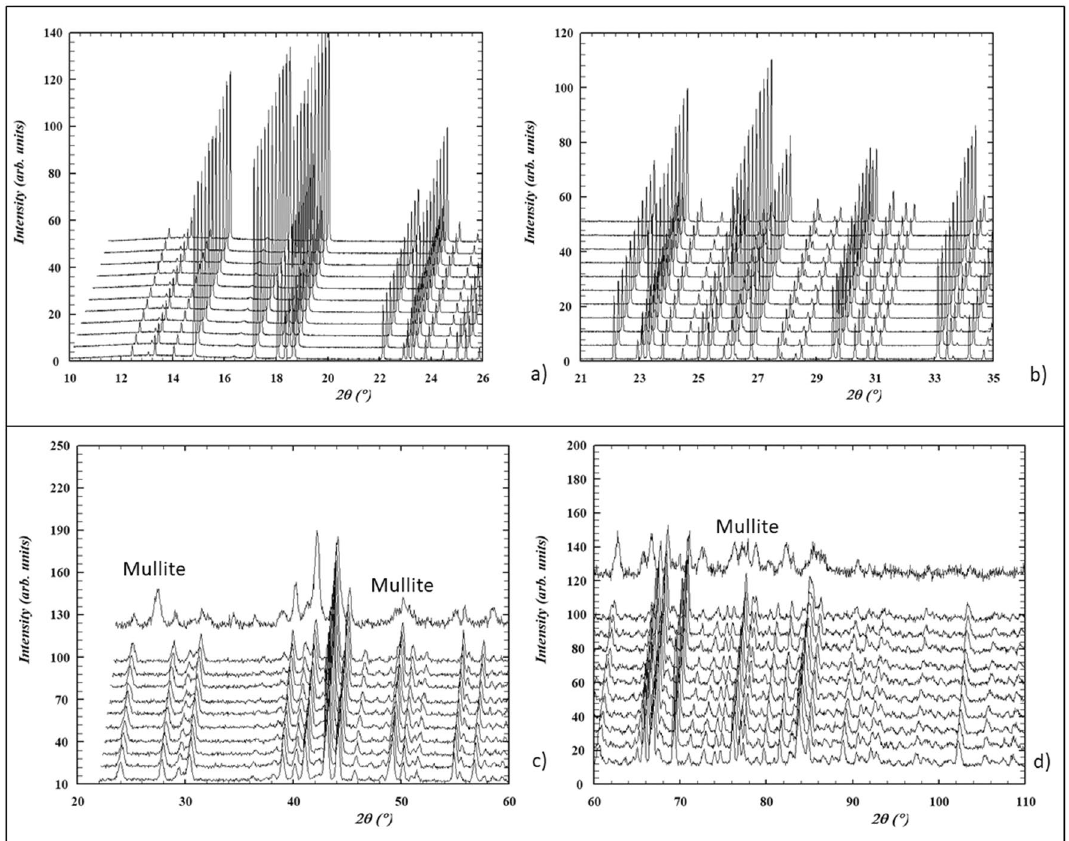
Figure 4. Cascade plots of PadPar topaz from Synchrotron ( a , b ) and Neutron ( c , d ) diffraction data. The samples were heated from room temperature to 1273 K (heating rate 5 K and 2 K/min for Synchrotron and Neutron data collection, respectively). Powder diffraction patterns recorded every 100 K are also shown. In neutron analyses, the rapid decomposition of the sample upon heating revealed the formation of mullite Al 4+2x Si 2−2x O 10−x . This image has been obtained with WinPLOTR from FullProf Suite (https ://www.ill.eu/sites / fullp rof/index .html) 77 .